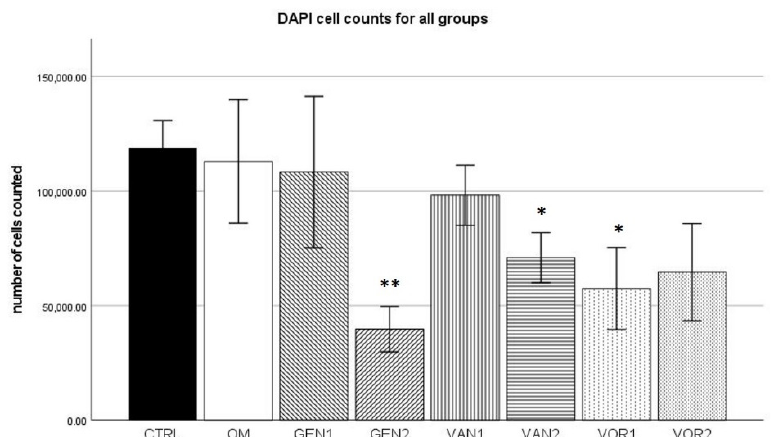
Figure 1. Mean cell count per group as established by the means of DAPI cell count. The error bars show the error of mean. Significances are indicated by stars: bold stars indicate a significance com- pared to the negative control CTRL, stars in italics indicate a significance compare to the osteogenic control OM. * = significance p ≤ 0.05, ** = significance p ≤ 0.01.